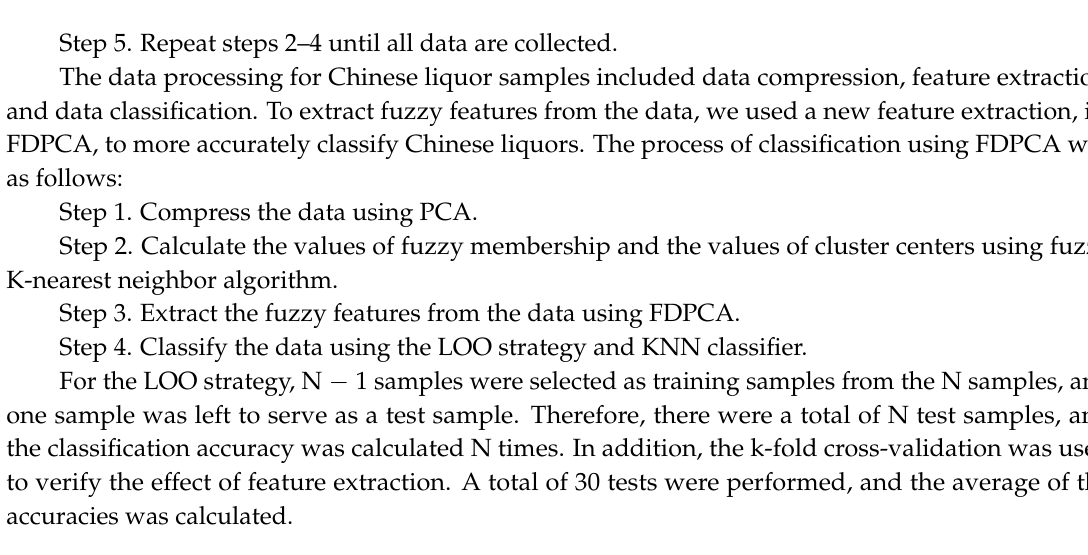
Figure 4. The response curve of pump (output) of Chinese liquor based on sensor array.